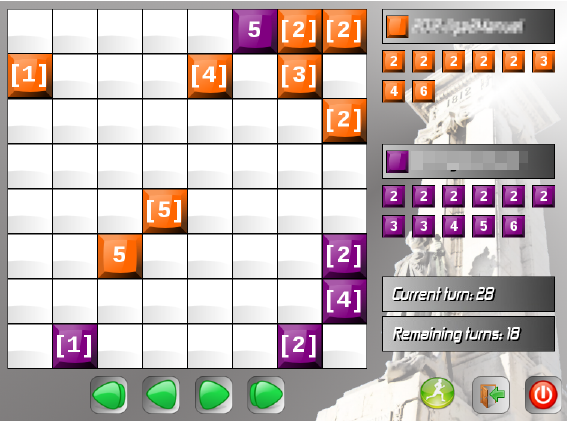
Figure 2. A screenshot of a